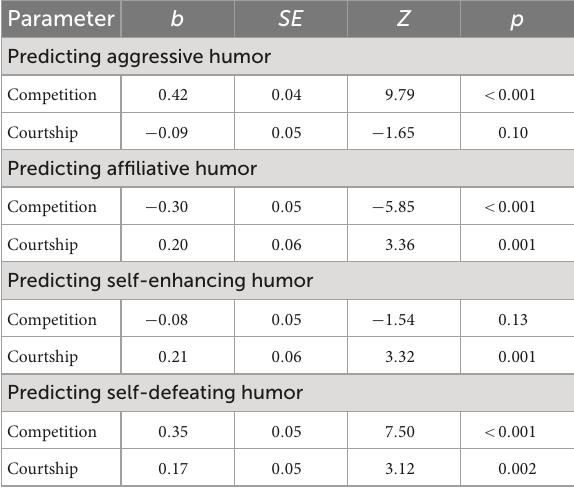
TABLE 2 Results of path models predicting self-reported use of humor from competition and